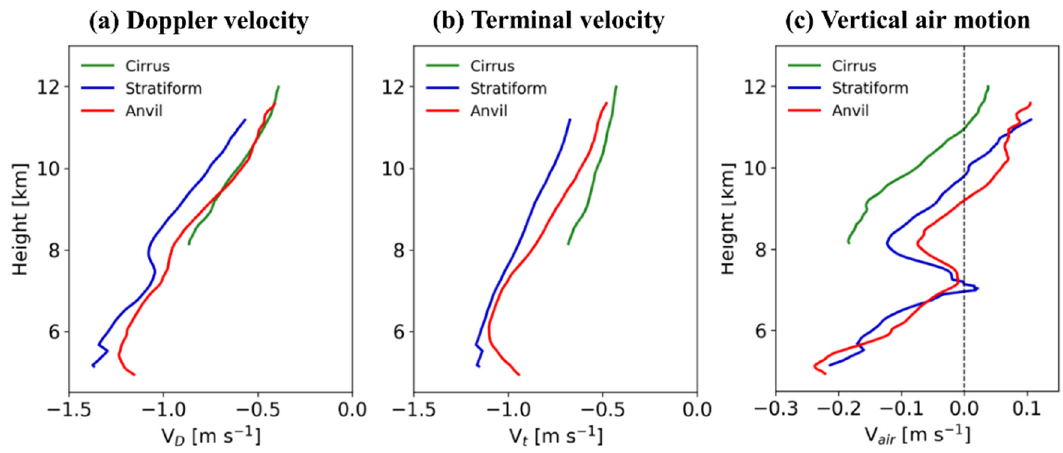
Figure 14. Averaged profiles of ( a ) V D , ( b ) V t , and ( c ) V air for cirrus, stratiform, and anvil cases.